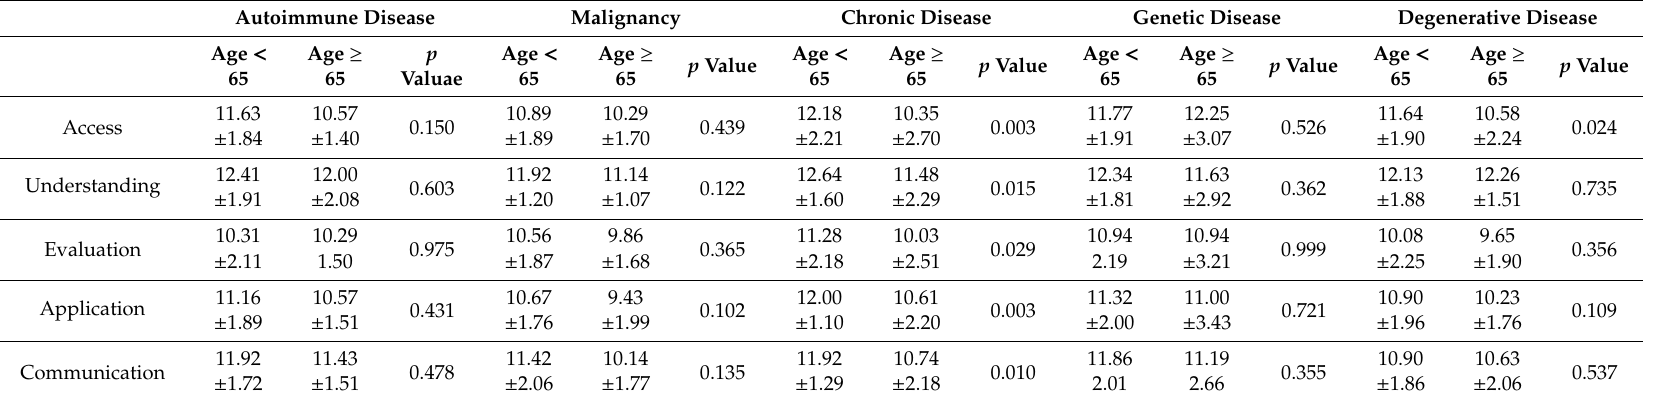
Table 4. The association between age ( < 65 or ≥ 65 years old) and all dimensions of MMHLQ divided by types of PSGs. Autoimmune